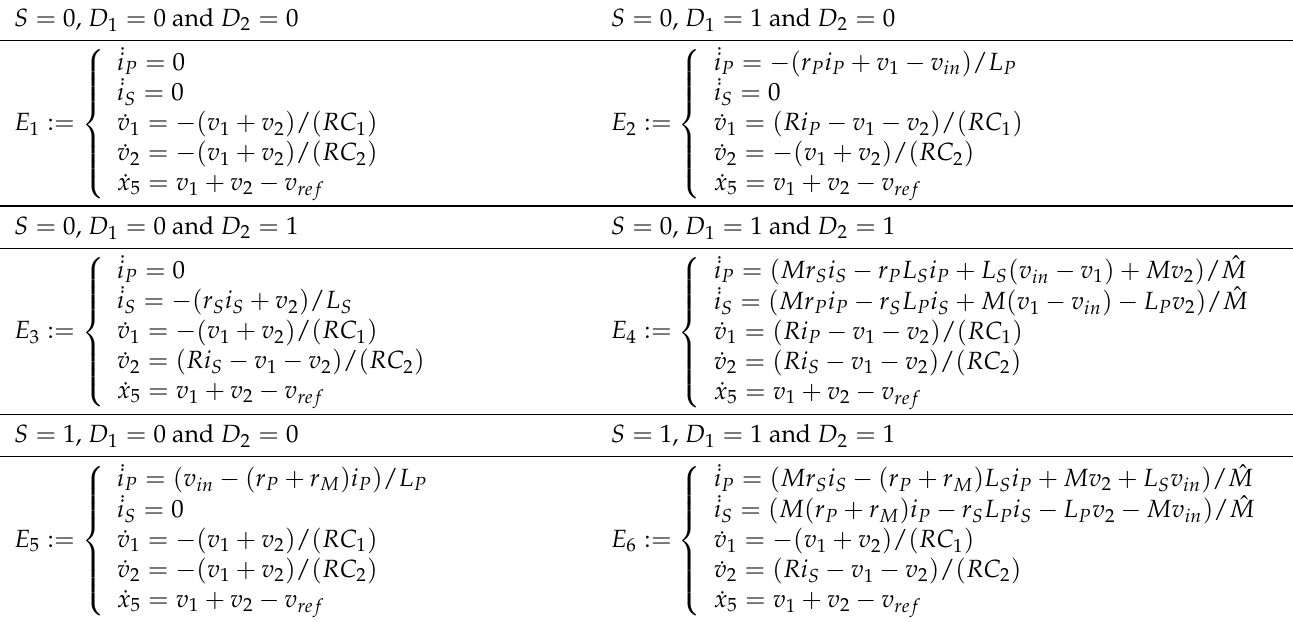
Table 1. Differential equations describing the six admissible topologies denoted as E i with i = { 1,2,3,4,5,6 } . S = 0, D 1 = 0 and D 2 = 0 S = 0, D 1 = 1 and D 2 =